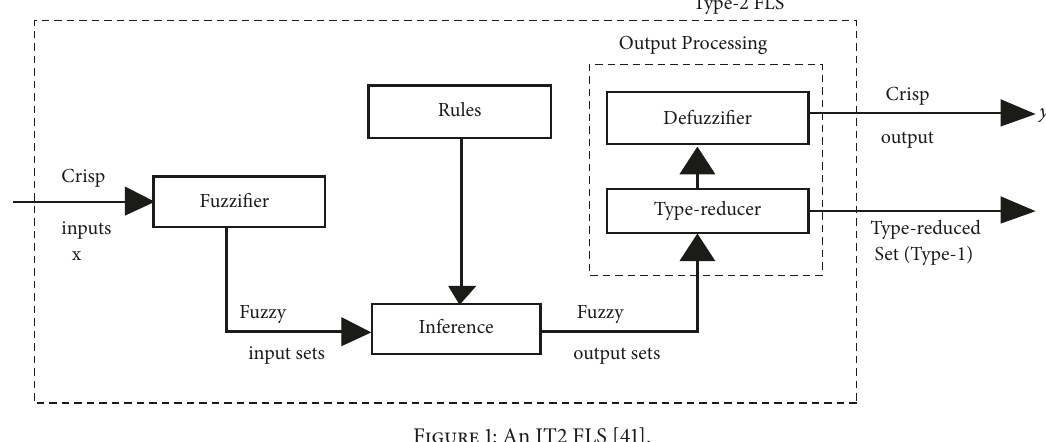
Figure 1: An IT2 FLS